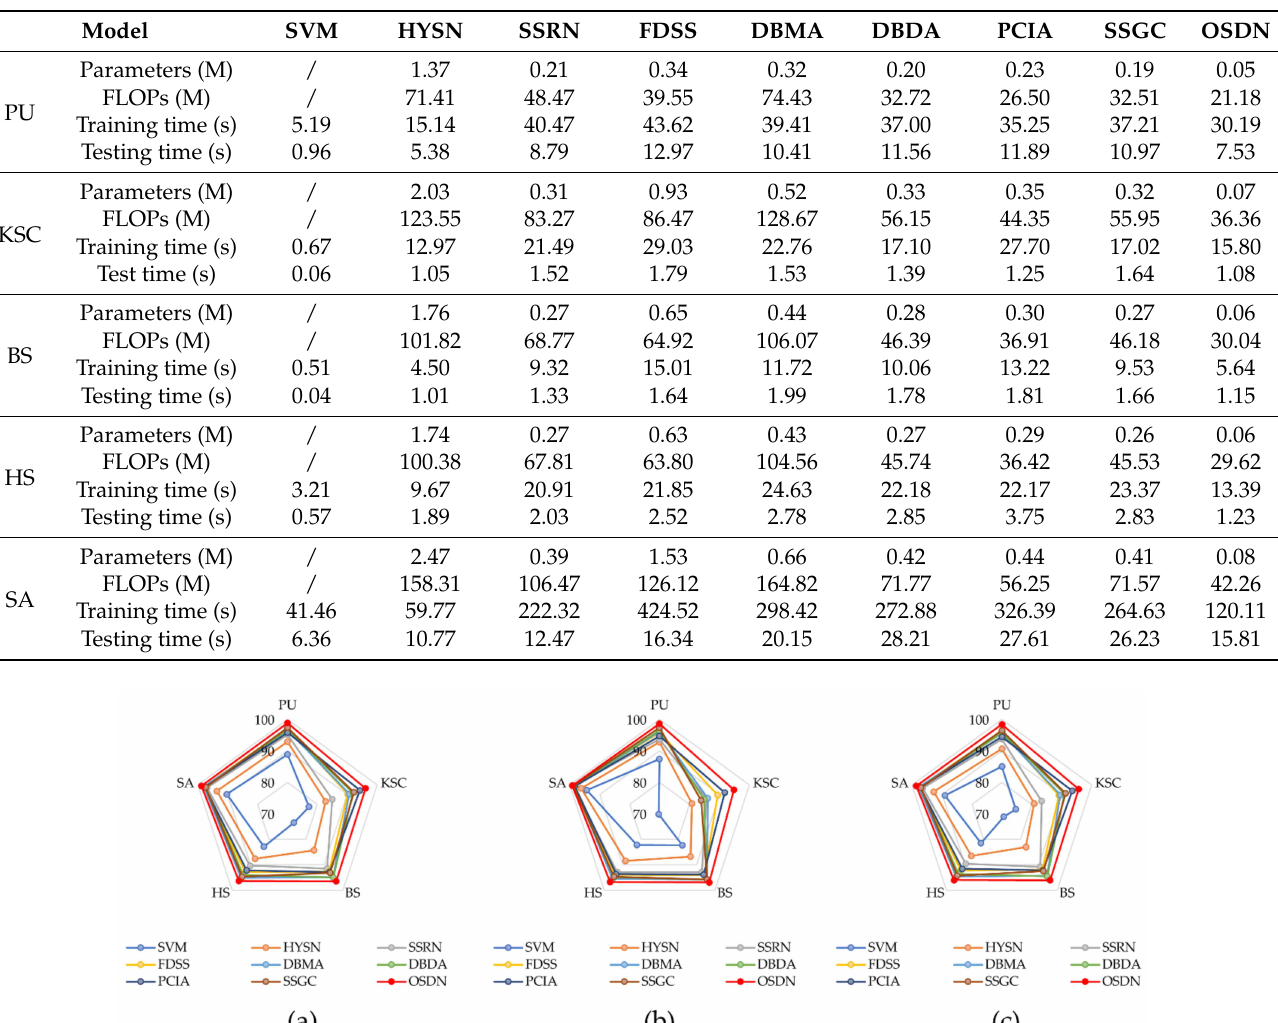
Table 16. The number of parameters, FLOPs, training time, and testing time of different methods for five datasets.